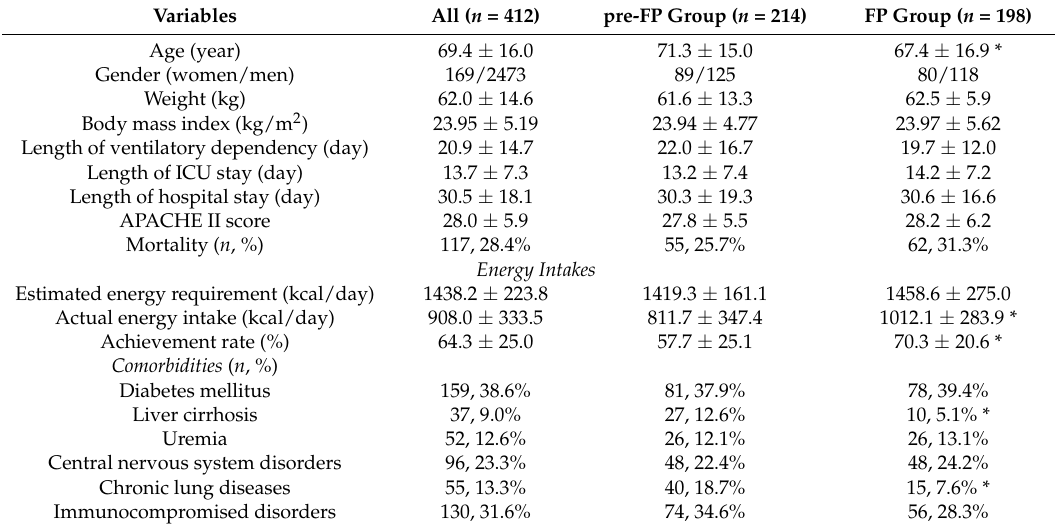
Table 1. Patients’ demographic characteristics, clinical outcomes, and energy intakes before and after the implementation of a volume-based feeding protocol.